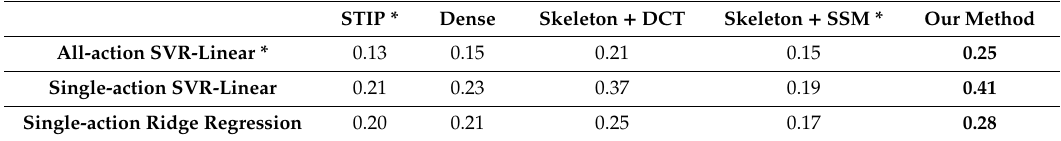
Table 2. Quality assessment results on the MIT figure skating dataset. The average rank correlation coe ffi cients between the predicted results and the ground truth of di ff erent feature representations and evaluation methods are